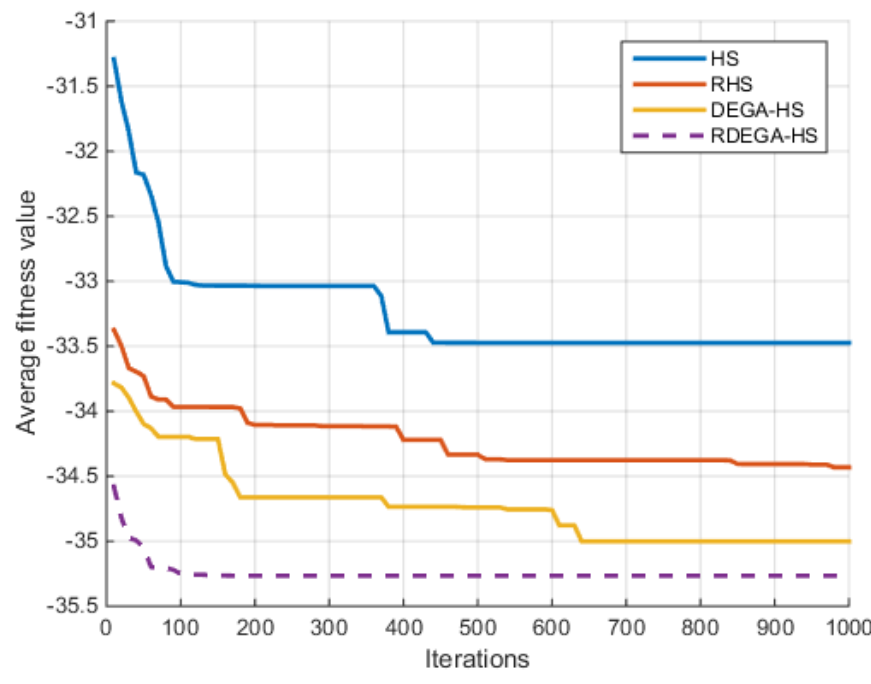
Figure 9. Change in average optimal fitness value of the Schwefel function with the number of iterations. Table 9. Results of the Schwefel function under different optimization